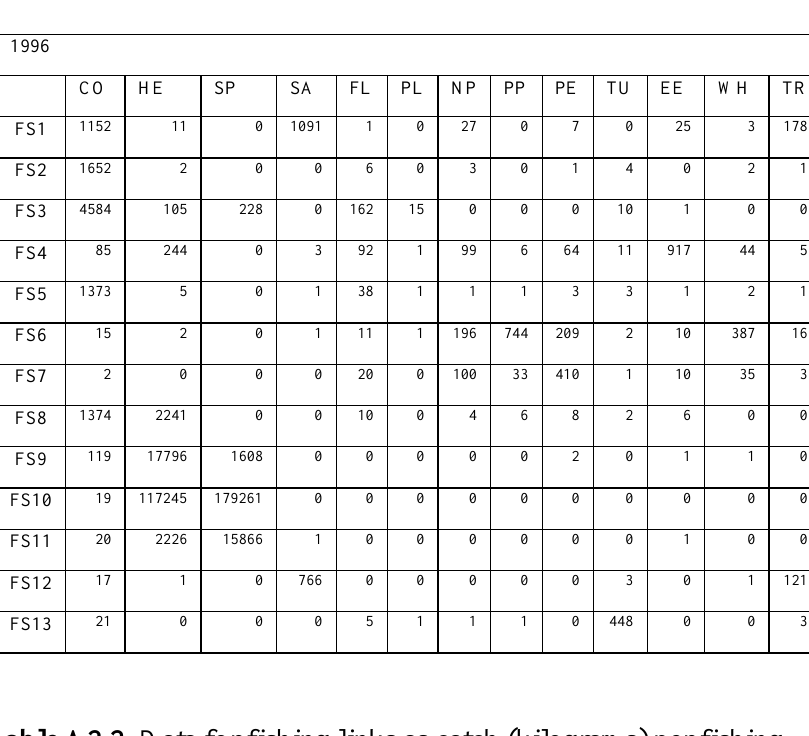
Table A2.2. Data for fishing links as catch (kilograms) per fishing event (trip) per an average fisher in each strategy in 2009 See Table S2a caption for how the data was used in network construction. The following abbreviations are used: FS: fishing strategy, CO: cod,